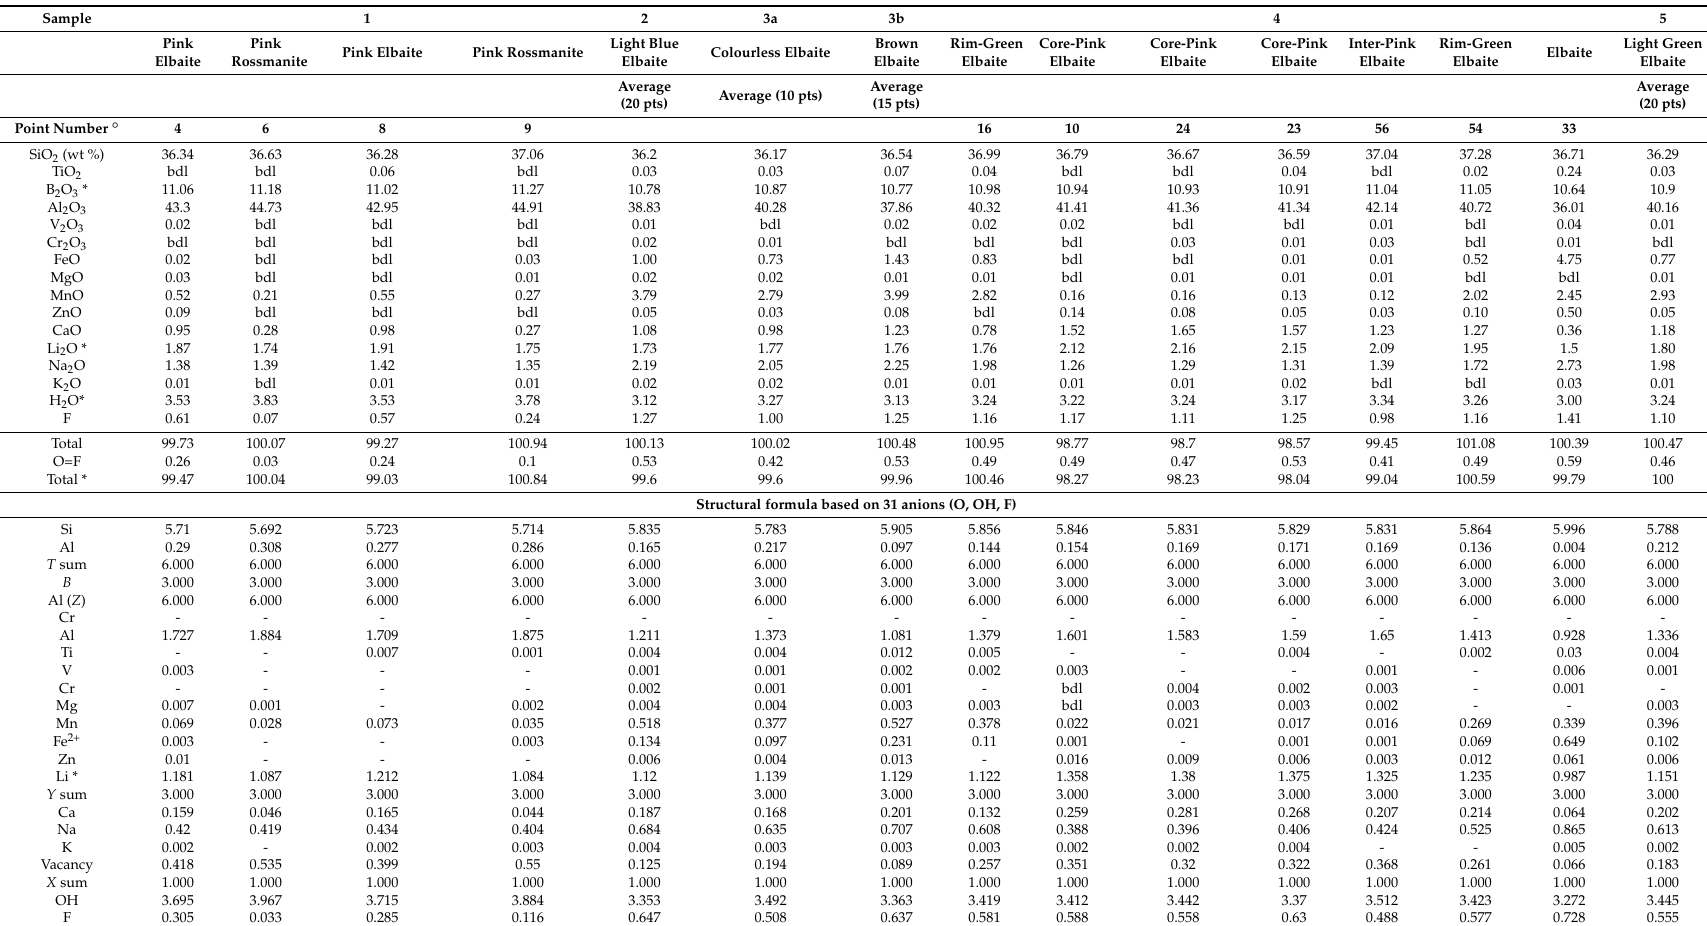
Table 2. Representative electron microprobe analyses of the studied